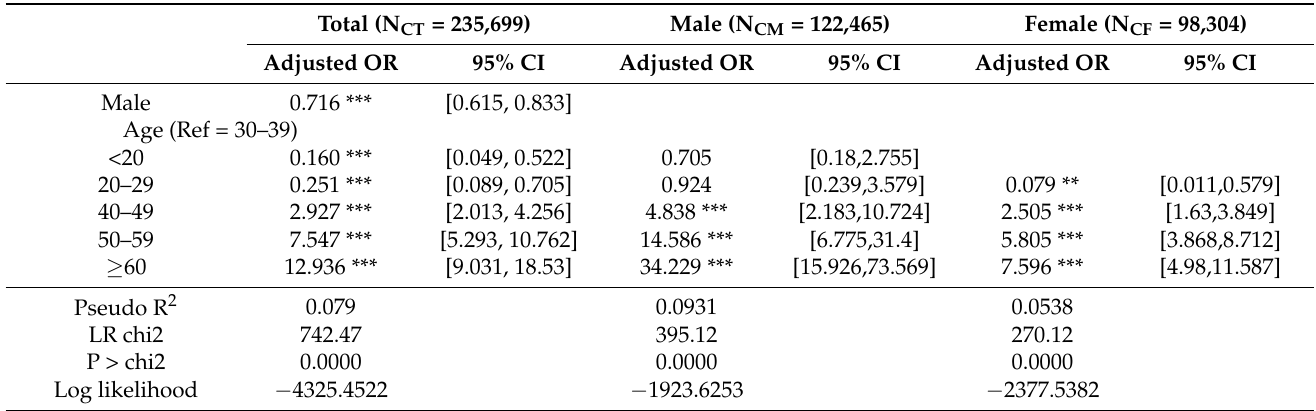
Table 4. Adjusted odds ratios (ORs) of logistic regressions for cancer